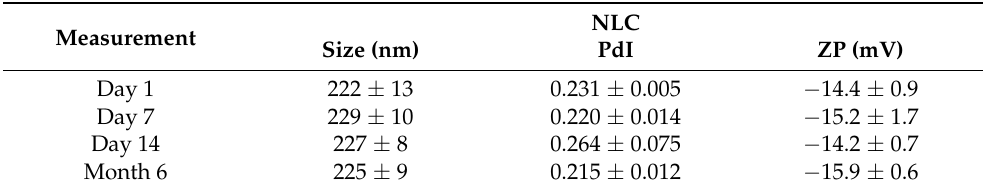
Table 1. The mean diameter (size), polydispersity index (PdI), and zeta potential (ZP) of the unloaded NLC formulations (mean ± SD, n =